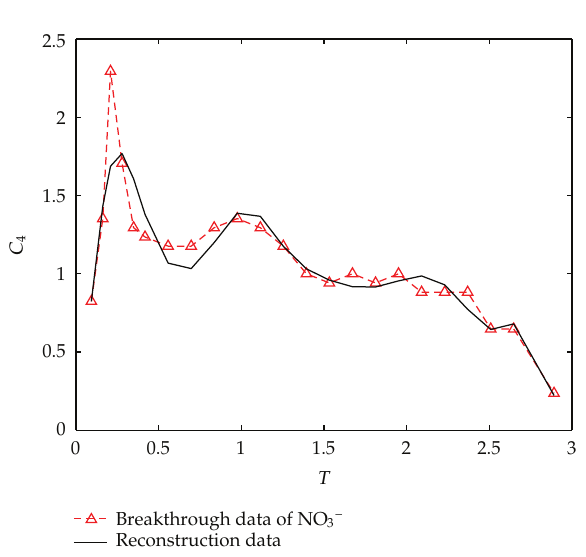
Figure 6: The breakthrough data and reconstruction data for NO 3 −